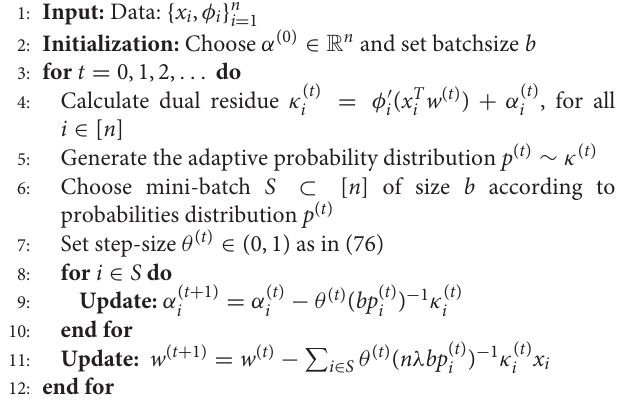
Algorithm 4 Mini-Batch